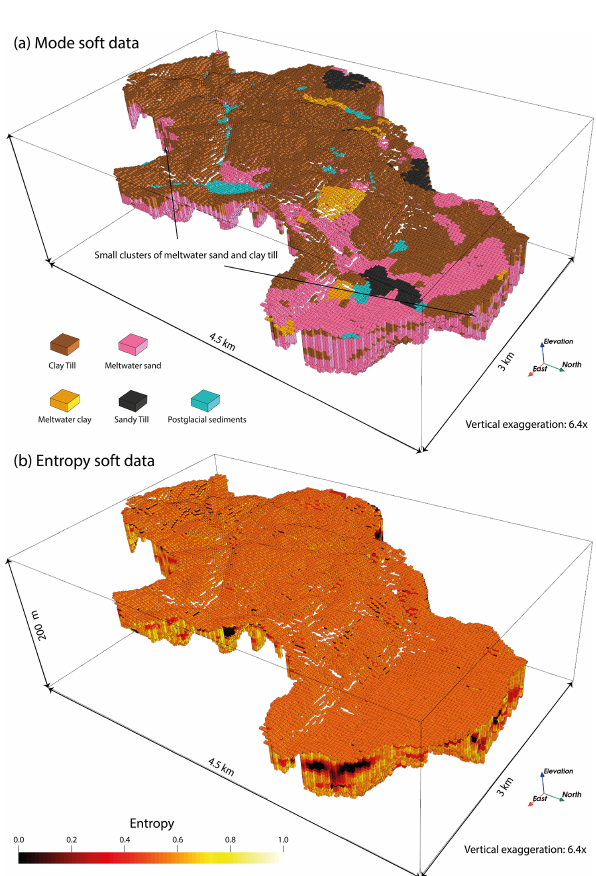
Figure 10. (a) Mode and (b) entropy for soft data from Fig. 9. Low entropy (certainty) is marked with black color, while white colors represent high entropy